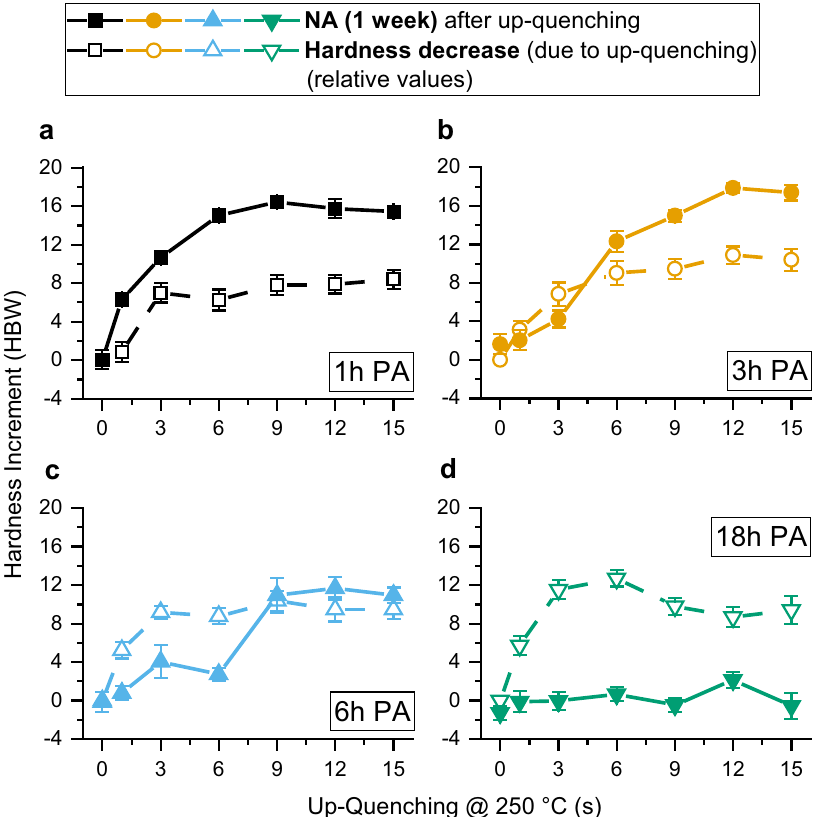
Fig. 3 Hardness increase after 1 week of natural aging following pre-annealing (PA) at 100°C and up-quenching. The 1-week hardness increase is measured after pre-annealing for a 1 h, b 3 h, c 6 h and d 18 h, and the application of up-quenching for durations of 1 – 15 s at 250 °C (solid lines). For comparison, the hatched lines show the drop in hardness from the pre-annealed state due to up-quenching only (compare to Fig. 2), depicted as absolute values. Long up-quenching times can promote increased natural aging kinetics by generating equilibrium vacancies in line with Fig. 1c. The error bars for each hardness measurement were determined from at least fi ve hardness indents and represent one standard